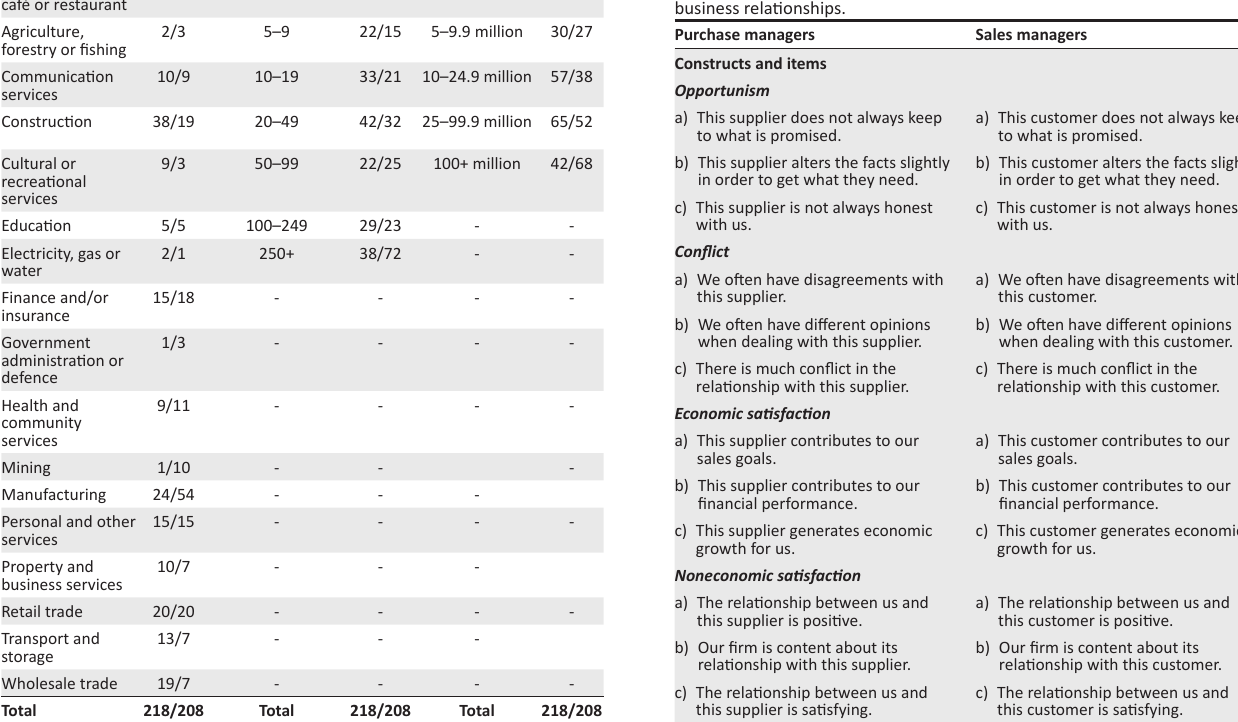
TABLE 2: Nature of business, full-time employee equivalent and annual turnover (purchase/ sales business relationships). Nature of business Count Full-time employee equivalent